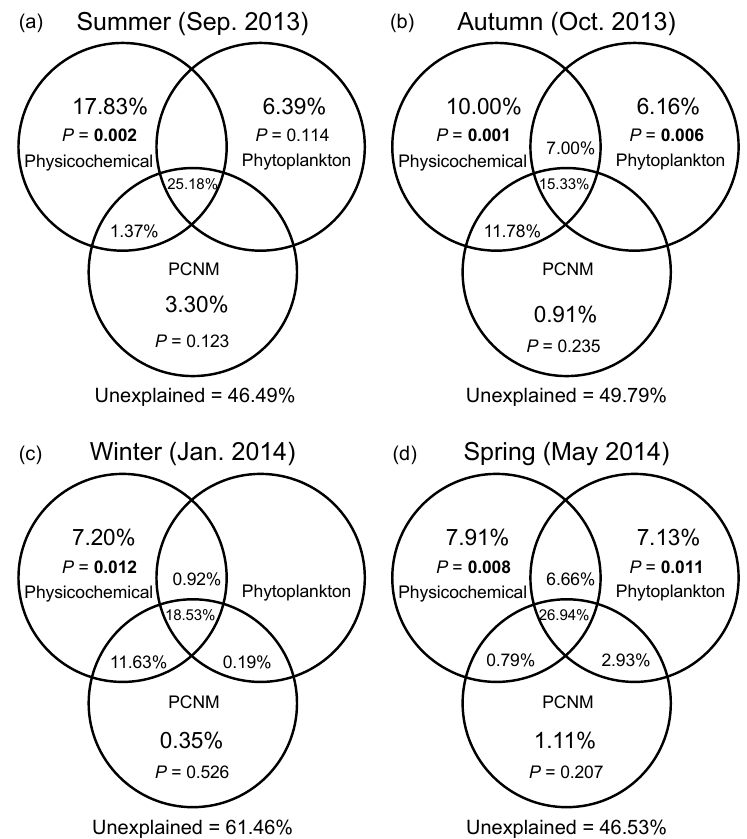
Figure 5. Variation partitioning of the Bray–Curtis dissimilarity between bacterial communities with physicochemical variables, eukaryotic phytoplankton, and spatial variables in the summer ( a ), autumn ( b ), winter ( c ), and spring ( d ). Physicochemical: physicochemical factors. Phytoplankton: eukaryotic phytoplankton at the order level based on the chloroplast 16S rRNA gene data. PCNM: spatial eigenvector converted from principal coordinates of neighbor matrices. Overlapped fractions represent the shared explained variance. Blank fractions present that R 2 values < 0 after being adjusted.